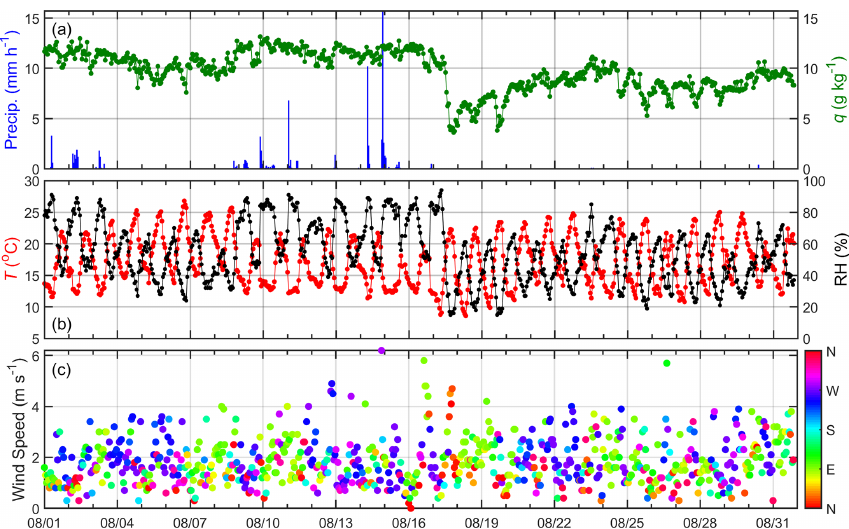
Figure 2. The time series of (a) precipitation in blue and specific humidity ( q ) in green, (b) temperature ( T ) in red, and relative humidity (RH) in black, as well as (c) wind speed and wind direction (in colors), based on hourly data in August from an automatic weather station in urban